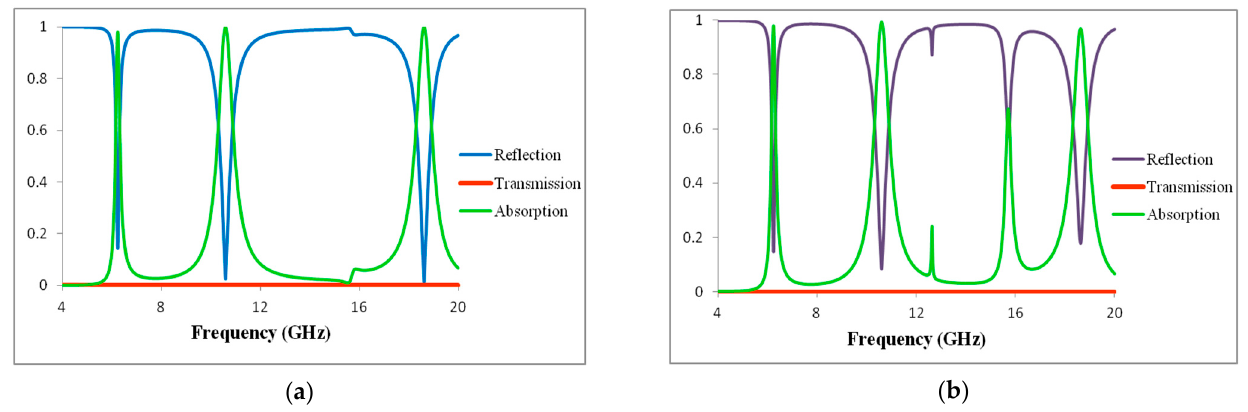
Figure 2. Absorption, reflection, and transmission results for ( a ) TE and ( b ) TM